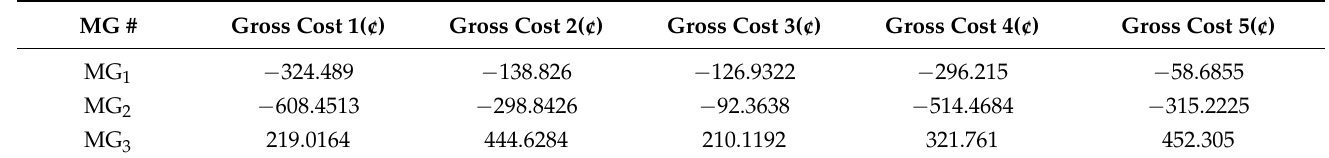
Table 8. Gross cost for five cases of unscheduled load with fixed time slots.